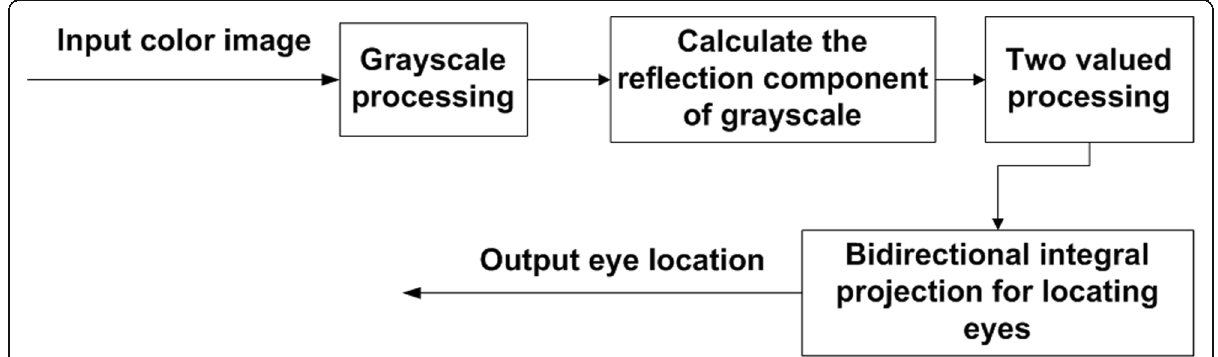
Fig. 6 Operation process of eye location algorithm based on two